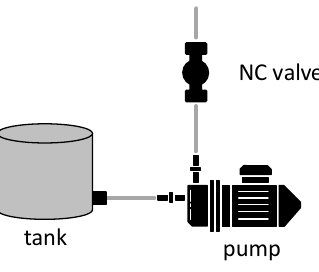
Figure 8. Patient bleeding module.